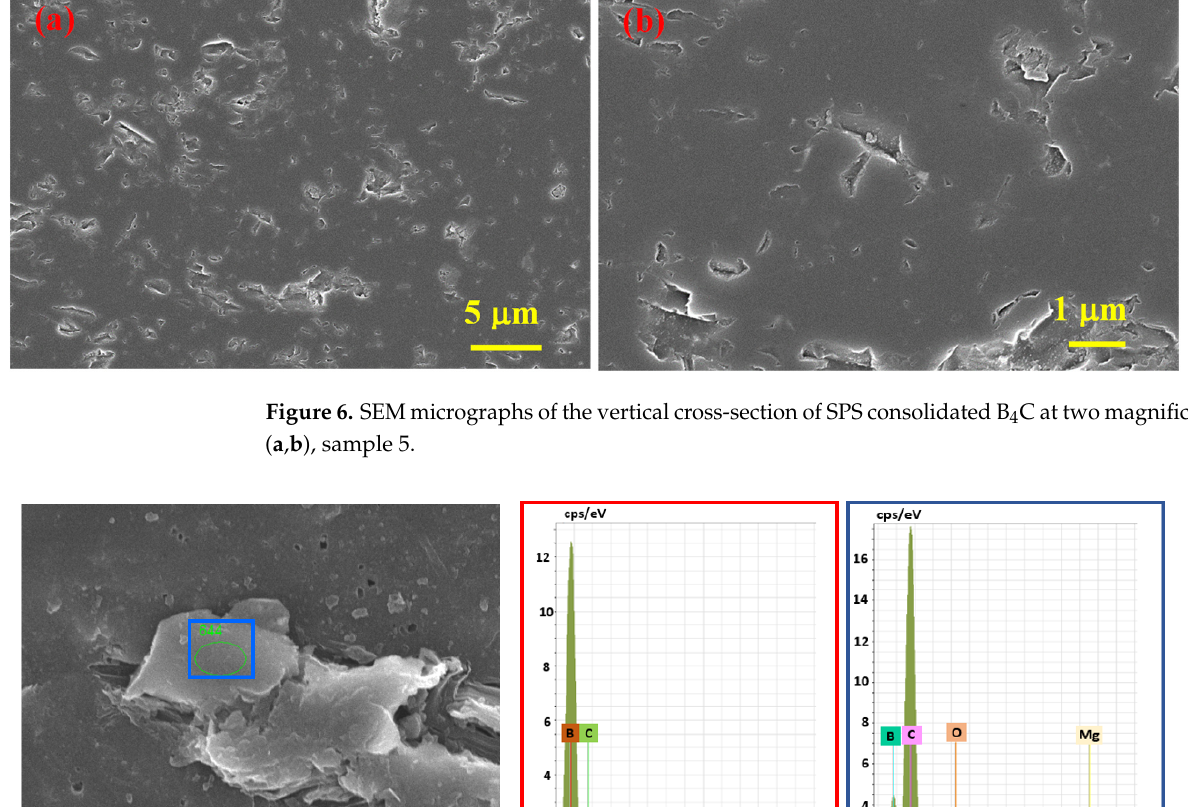
Figure 6. SEM micrographs of the vertical cross-section of SPS consolidated B 4 C at two magnifica- tions ( a , b ), sample 5.